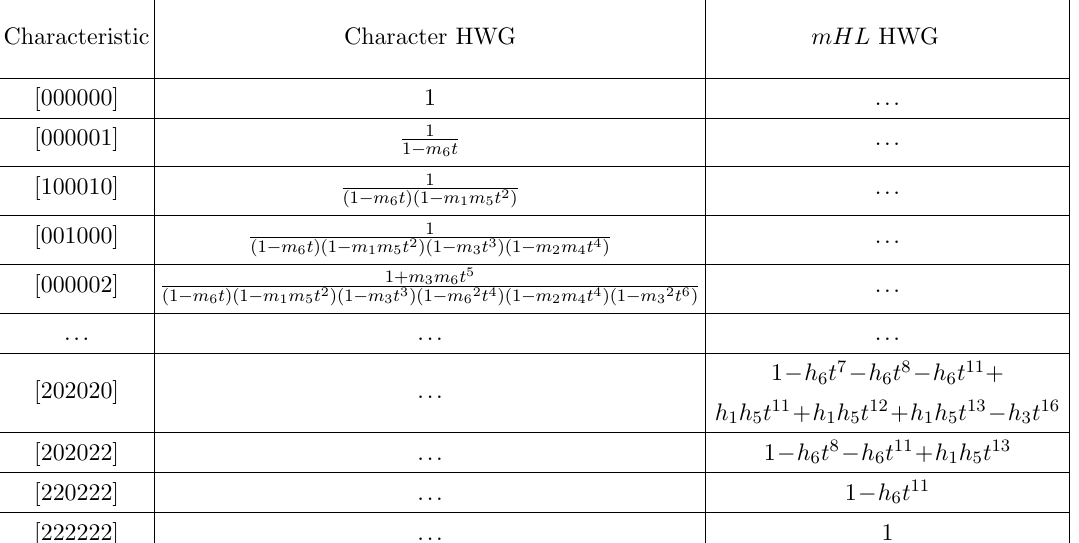
Table 17 . E 6 orbits and HWGs. An mHL HWG of 1 denotes mHL E 6 of the Hasse diagram remain to be